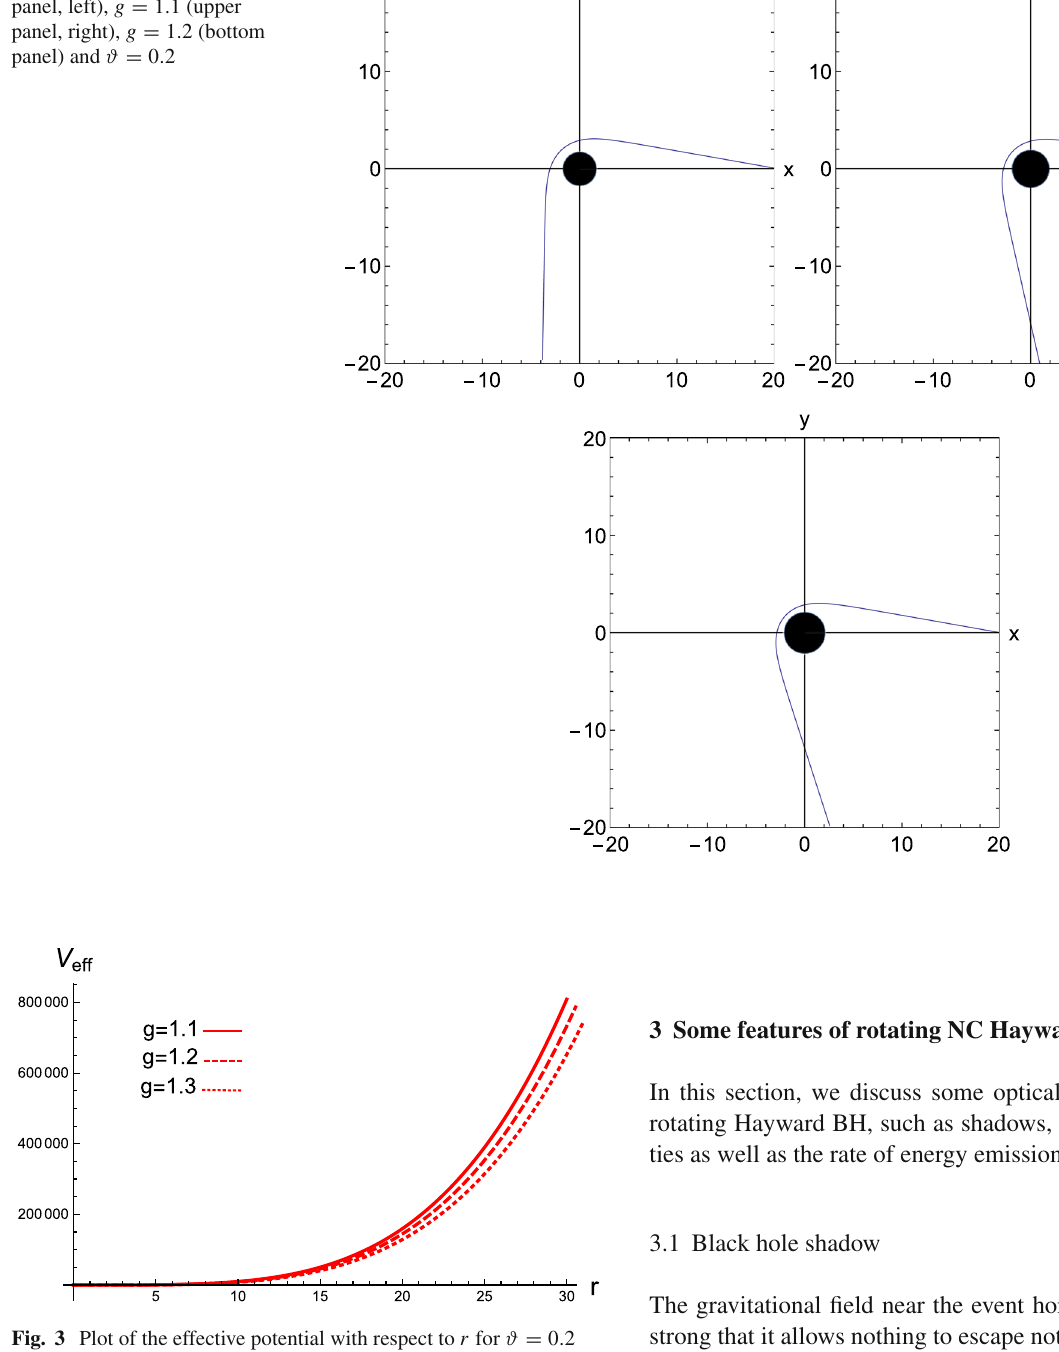
Equations (13)–(20) provides the expressions of the criti- cal impact parameters, ξ and η which describe the shadow’s contour (will be discussed in the next section) for the NC Hayward